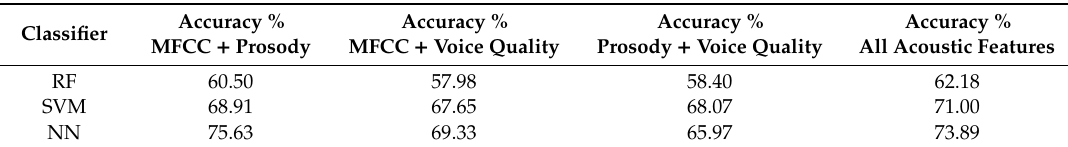
Table 9. Accuracy results for various acoustic feature combinations.